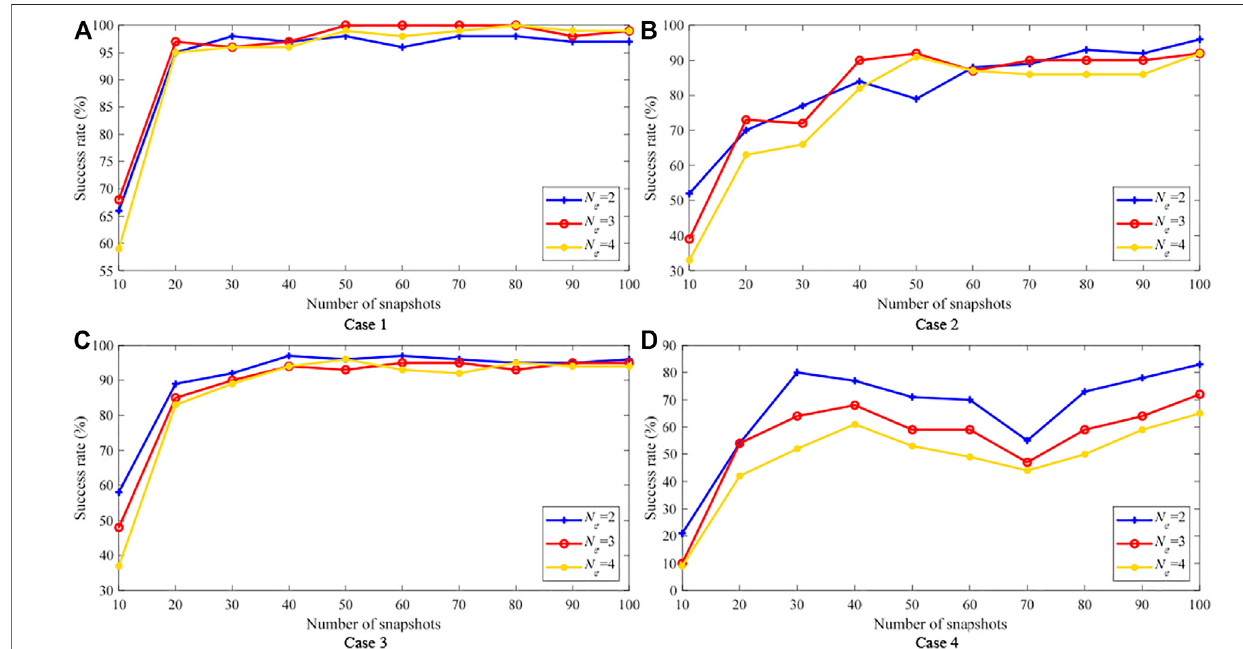
FIGURE 2 | PEI success rate of the IEEE 14-bus